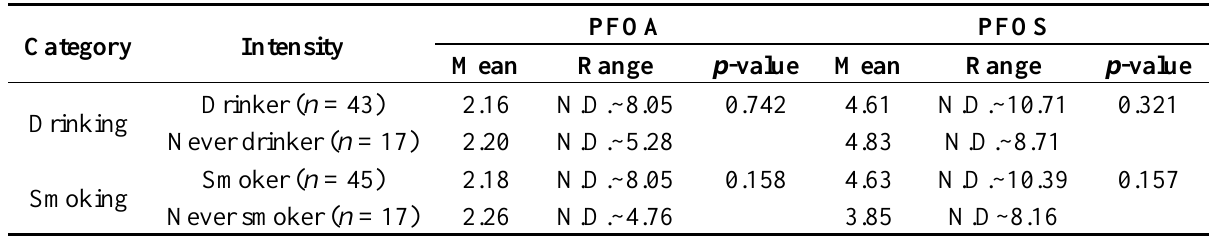
Table 3. Levels of PFOA and PFOS according to smoking habits and alcohol consumption (ng/mL).